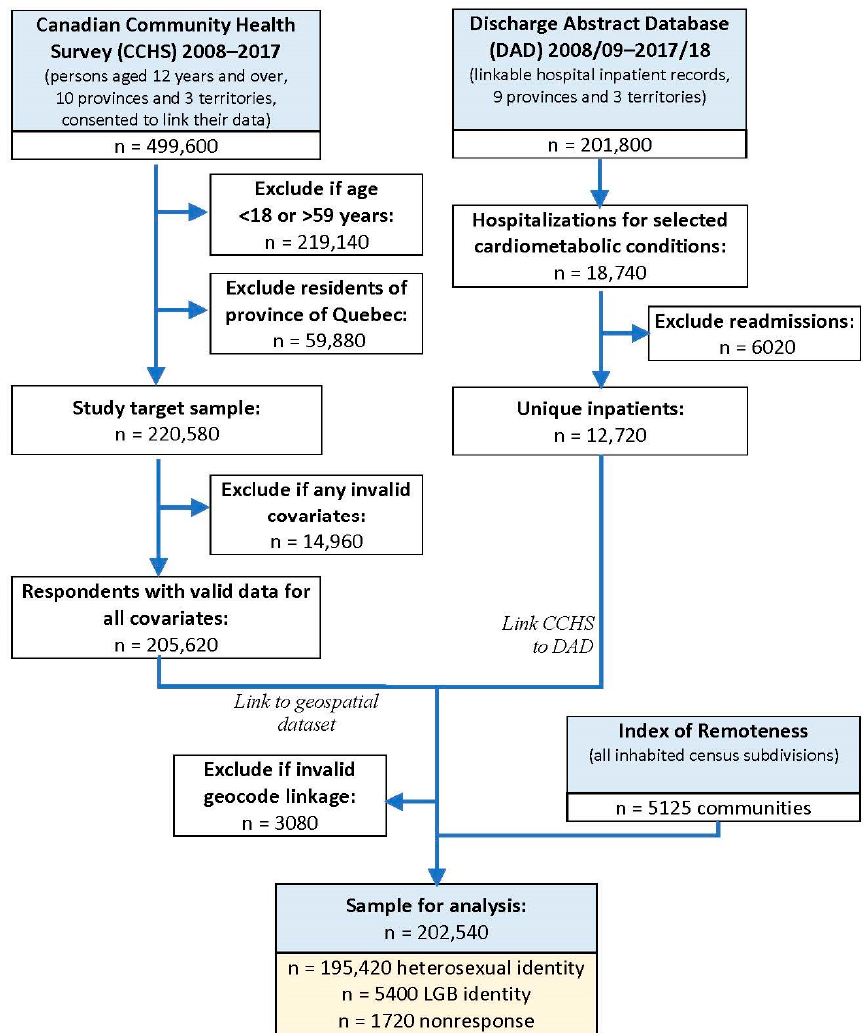
Figure 1. Flowchart of data linkage for the study population.